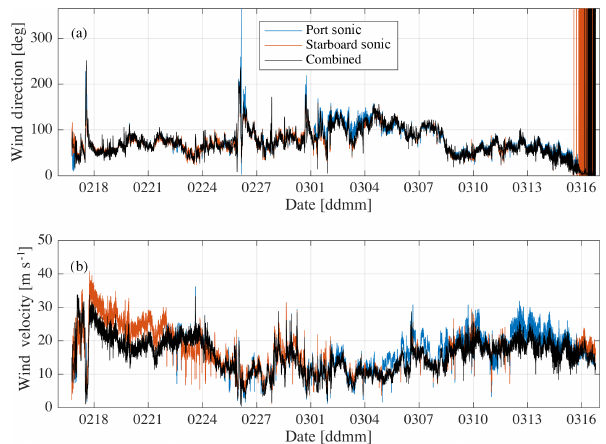
Figure 16. (a) Time series of wind directions during the entire cruise, as measured by the port side and starboard side ultrasonic anemometers and the time series constructed by combining the two. These winds have not been corrected for flow distortion. (b) Same as in (a) , but for wind